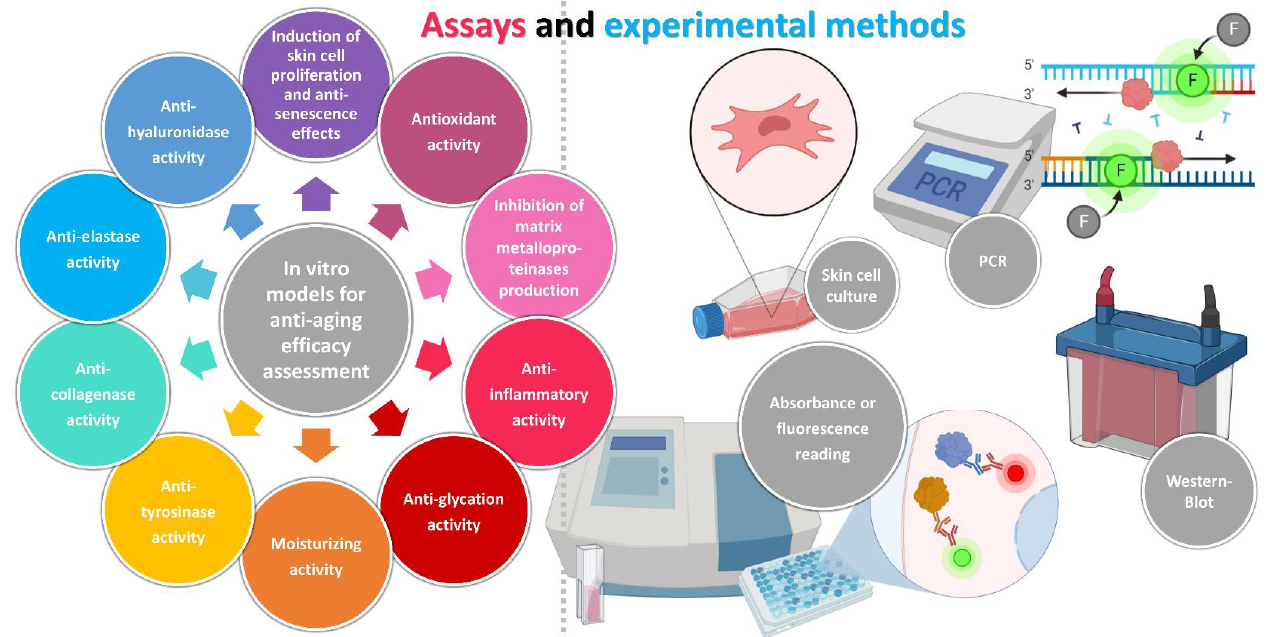
Figure 2. Schematic representation of the assays and corresponding experimental methods that can be used for the assessment of skin anti-aging activity (produced with